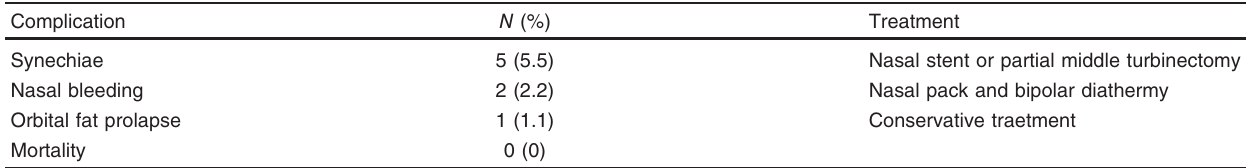
Table 5 Mortality and complications